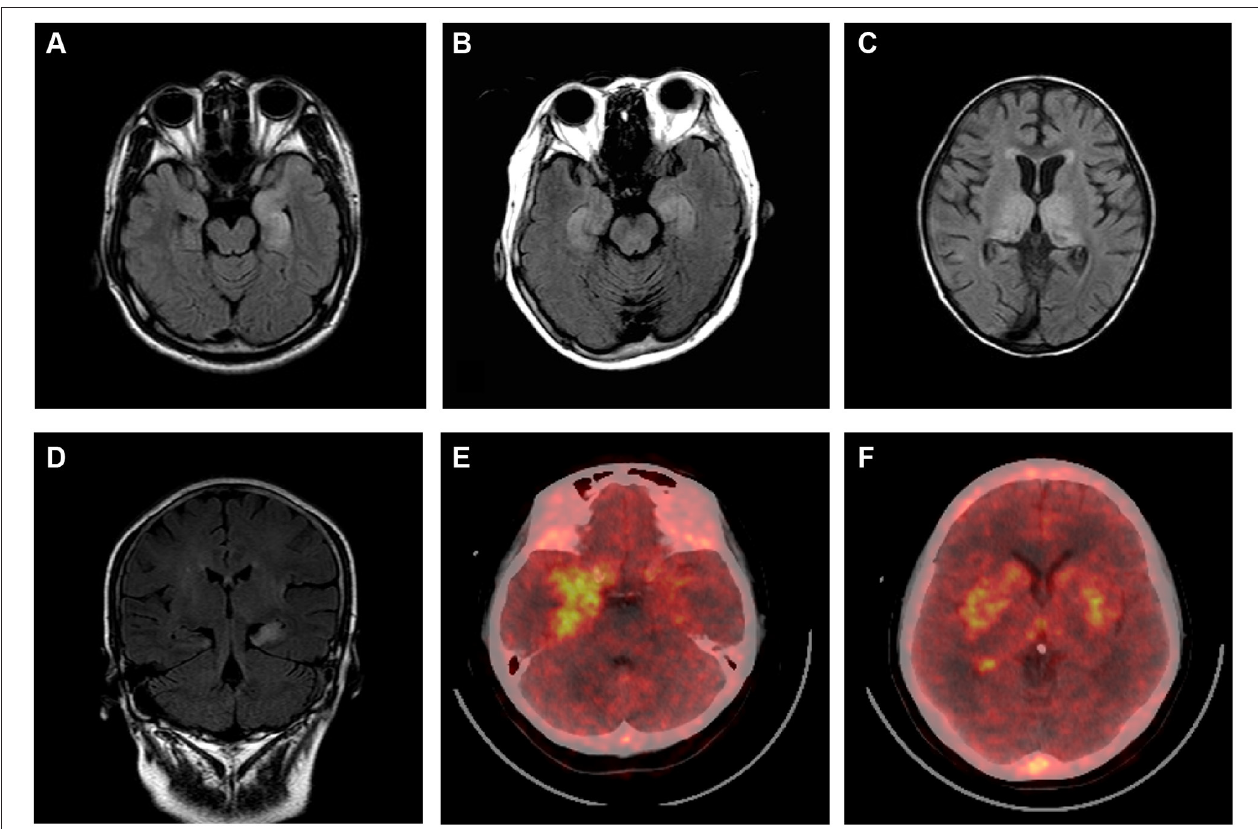
FIGURE 3 | Brain MRI and positron emission tomography (PET) scans of patients with autoimmune encephalitis. Brain MRI T2-flair images (A–D) . Bilateral high signal in the temporal lobe (A,B,D) . Bilateral abnormal signals in the medial temporal lobe and occipital lobe (C) . PET images show temporal cortex (more significant on the right) (E) and bilateral hypermetabolism in the basal ganglia (F) .